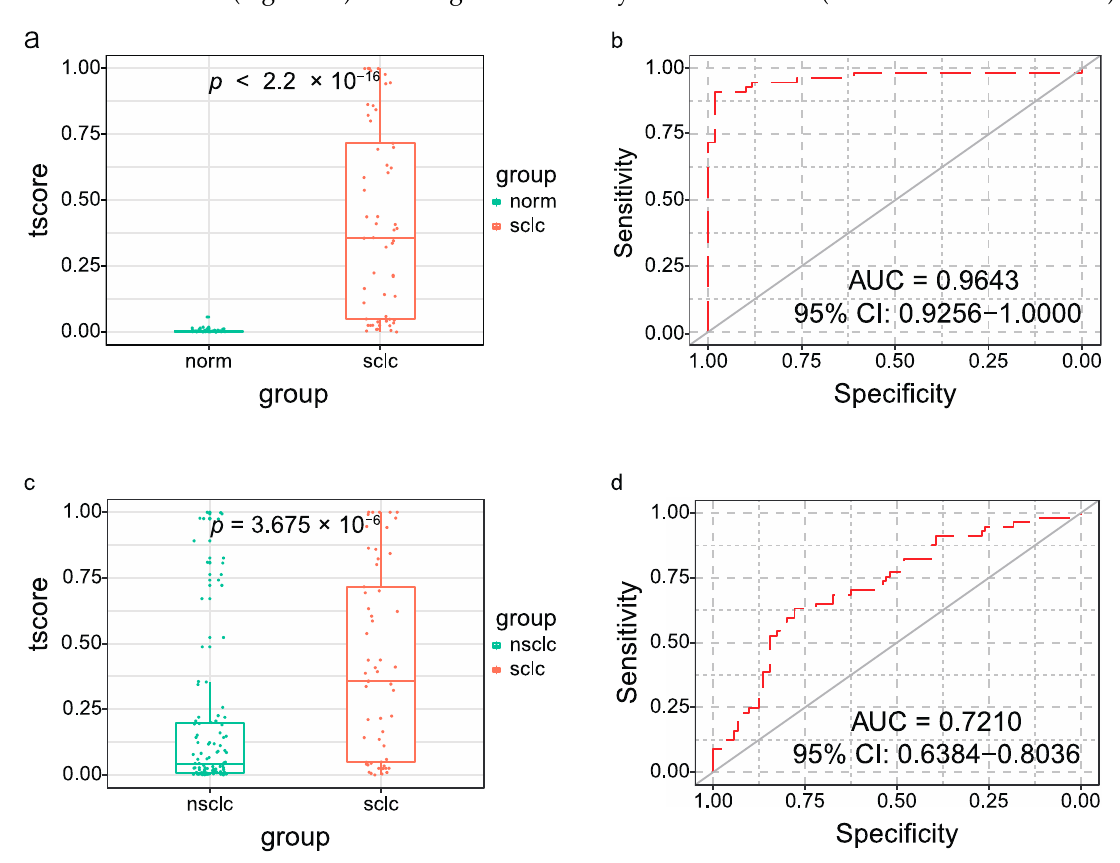
Figure 6. T-scores for the diagnosis of SCLC. T-scores in distinguishing SCLC from healthy controls ( a ) and SCLC from NSCLC ( c ). The ROC curve for the t-signature in SCLC and healthy controls ( b ), SCLC and NSCLC ( d ). NSCLC: non-small-cell lung cancer.